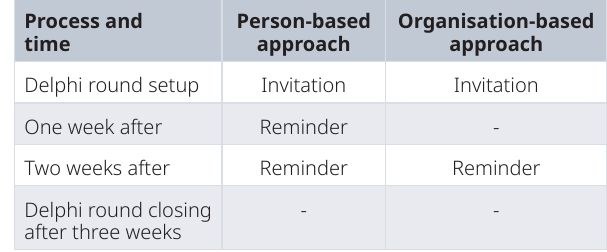
Table 2. Reminder strategy of each online Delphi round. Process and time